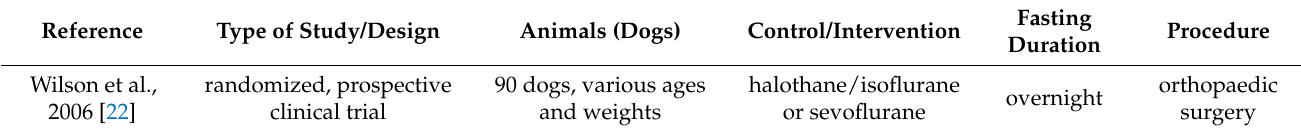
Table 3. Intervention: inhalant agents. Characteristics of the study in dogs.